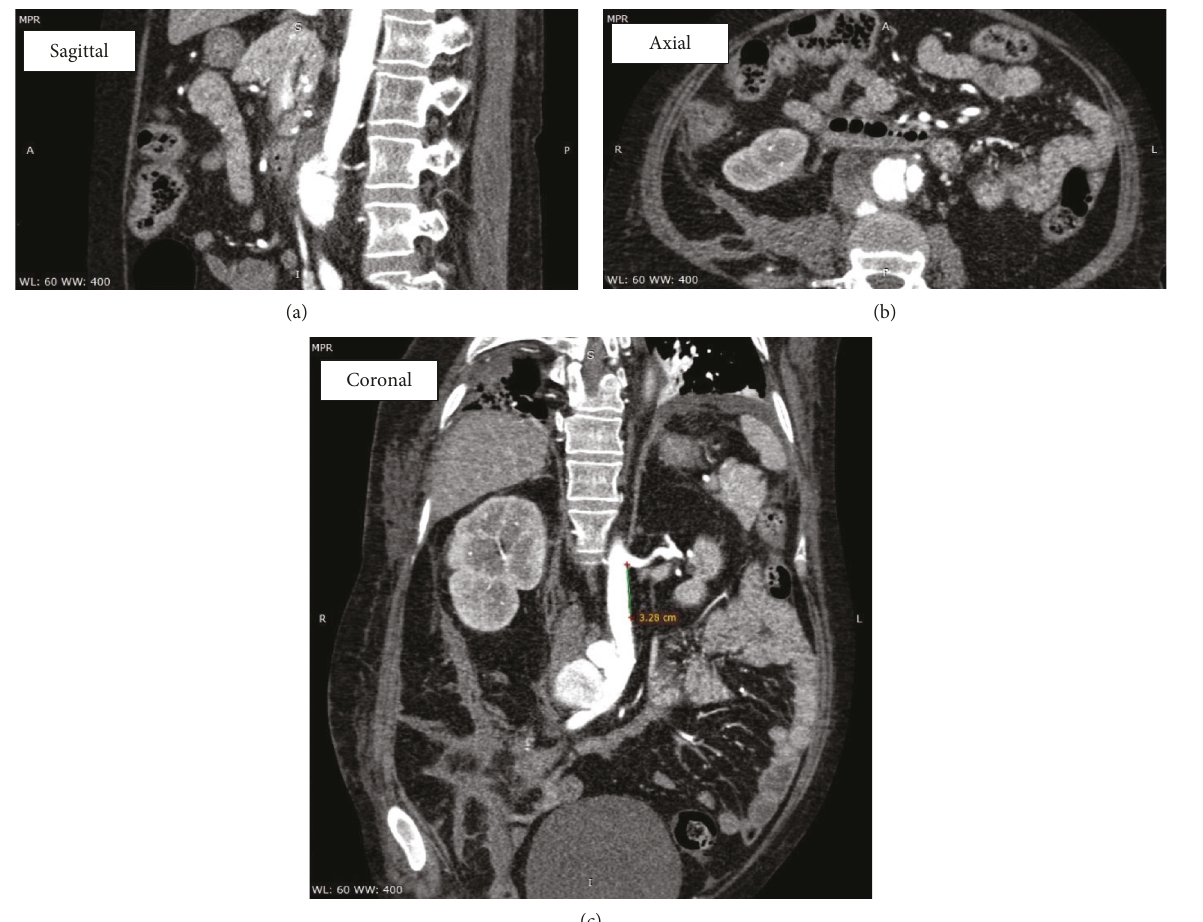
Figure 2: Multiplanar images demonstrating the infrarenal abdominal aorta. The dissection is seen arising 3.3 cm distal to the take-o ff of the left renal artery and extending to the iliac bifurcation, with an involved length of 7 cm.